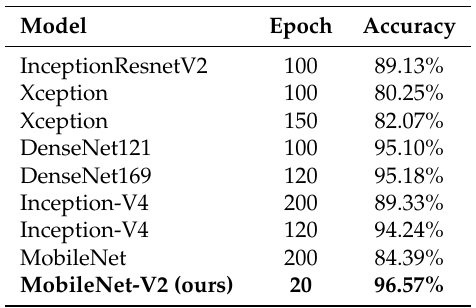
Table 1. Epochs and accuracy results in test data compared with [39] using the TrashNet